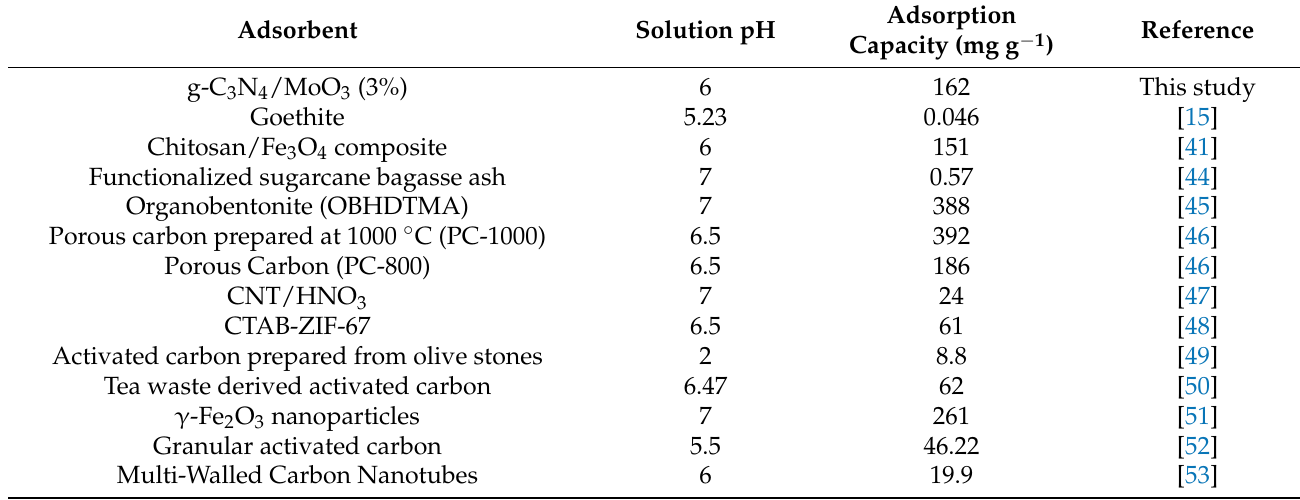
Table 3. Adsorption capacity of adsorbents for the removal of diclofenac vs g-C 3 N 4 /MoO 3